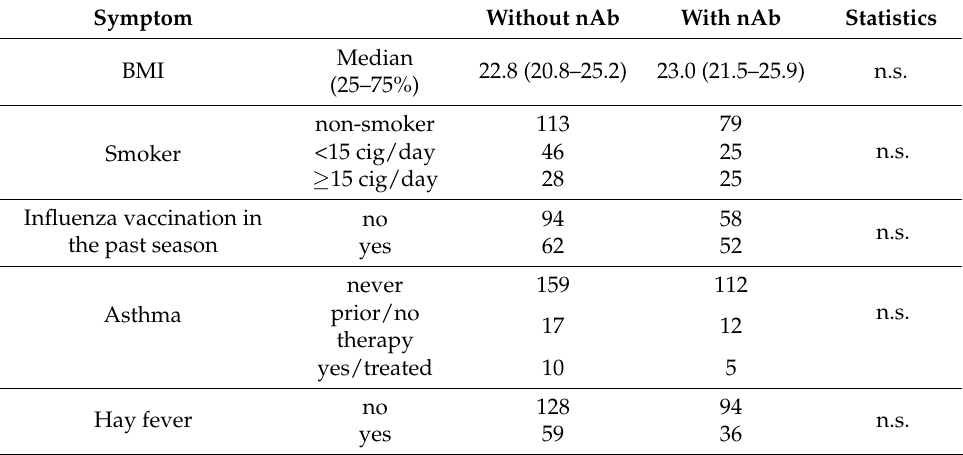
Table 2. Predisposing factors and neutralizing